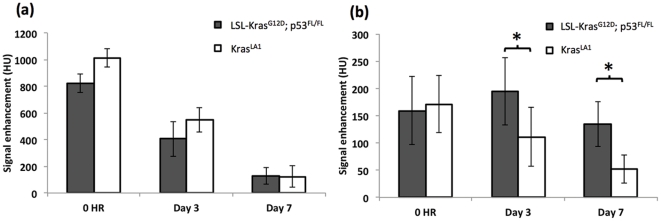
Dynamic signal enhancement in (a) blood and (b) nodules, in the two primary lung cancer models. Errors bars represent standard deviations (* indicates p<0.05).